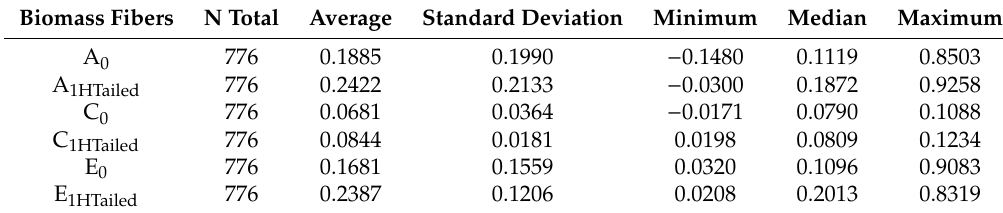
Table 3. Average Sound Absorption of Biomass Fiber Materials with Single Tailed Cavity.